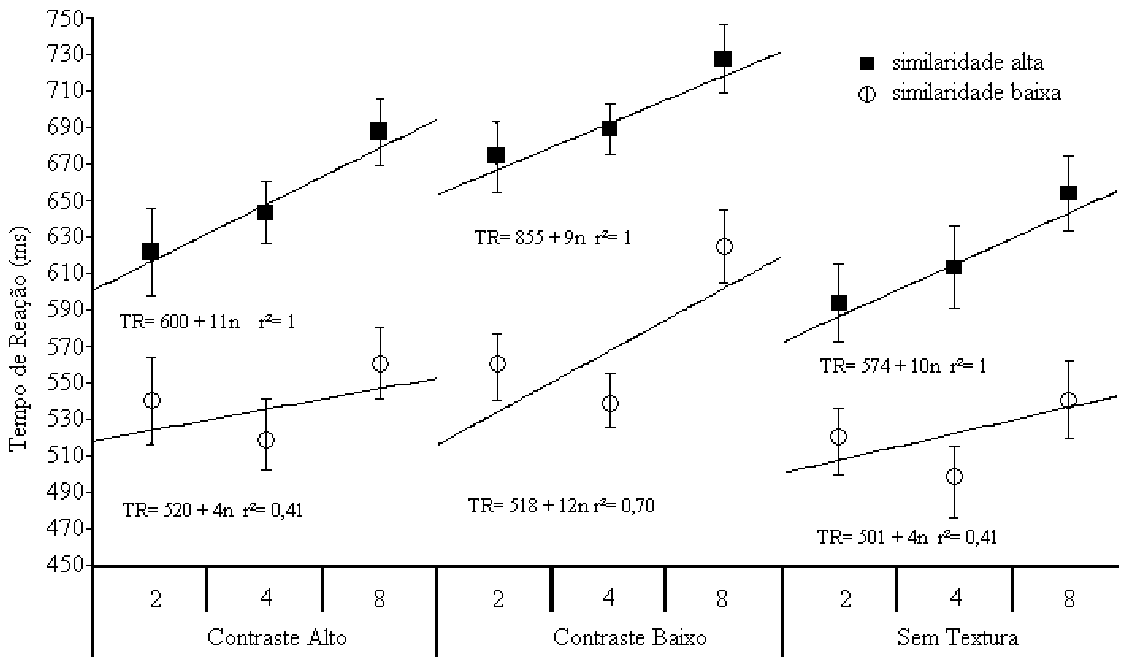
Figura 3 . Experimento 2. Média do tempo de reação (TR) em função dos seguintes fatores: contraste da luminância (alto, baixo, sem textura); número de estímulos relevantes (2,4,8); similaridade alvo / distratores (alta, baixa). A função TR e o quadrado do coeficiente